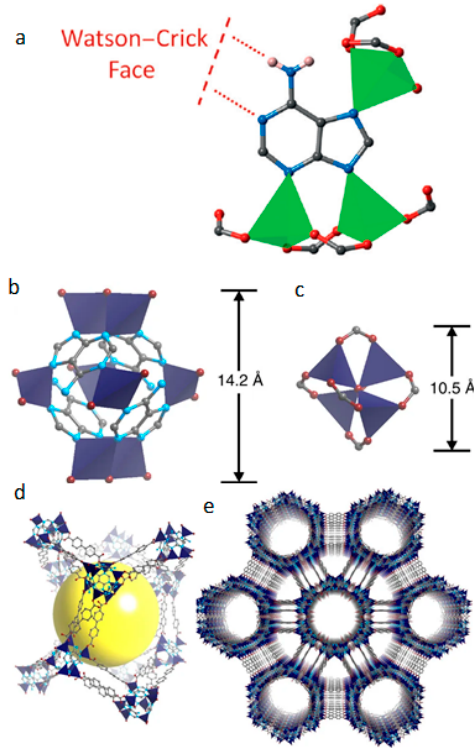
Figure 3. ( a ) Open Watson–Crick sites and the coordination environment of adenine in ZnBTCA [59]. ( b , c ) A comparative illustration of the structure and size of the building units in bio-MOF-100 and the basic zinc-carboxylate building [57]. ( d , e ) The 3-D crystal structure of bio-MOF-100 where the cavities (yellow sphere) and the large channels can be seen (Zn 2+ : green or dark blue tetrahedra, C: grey spheres, O: red spheres, N: blue spheres, H: omitted for clarity) [57].